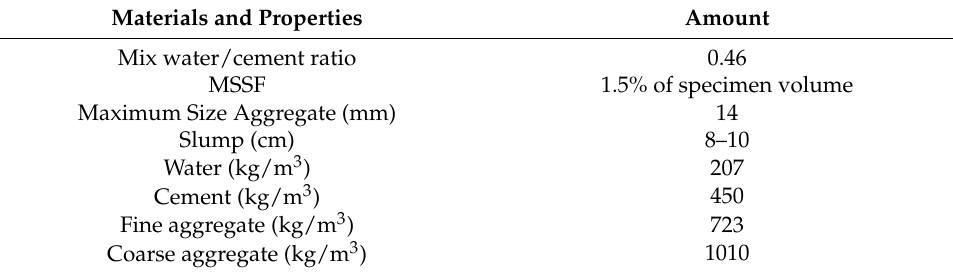
Table 2. Details of mix proportion and properties.